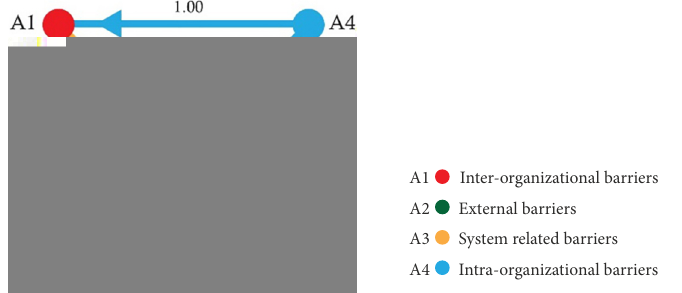
Figure 4. The visualization of the credal ranking for main barriers